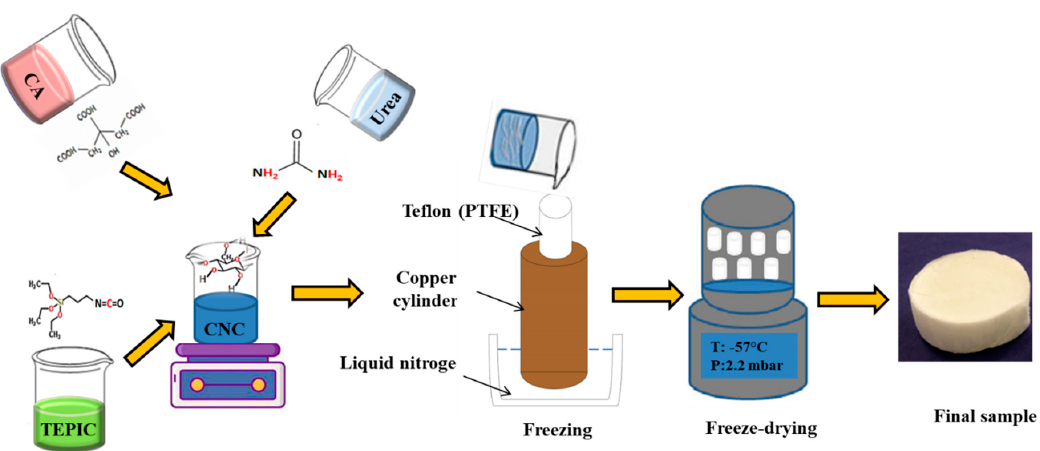
Figure 1. Schematic of the fabrication method of the CNC aerogels.